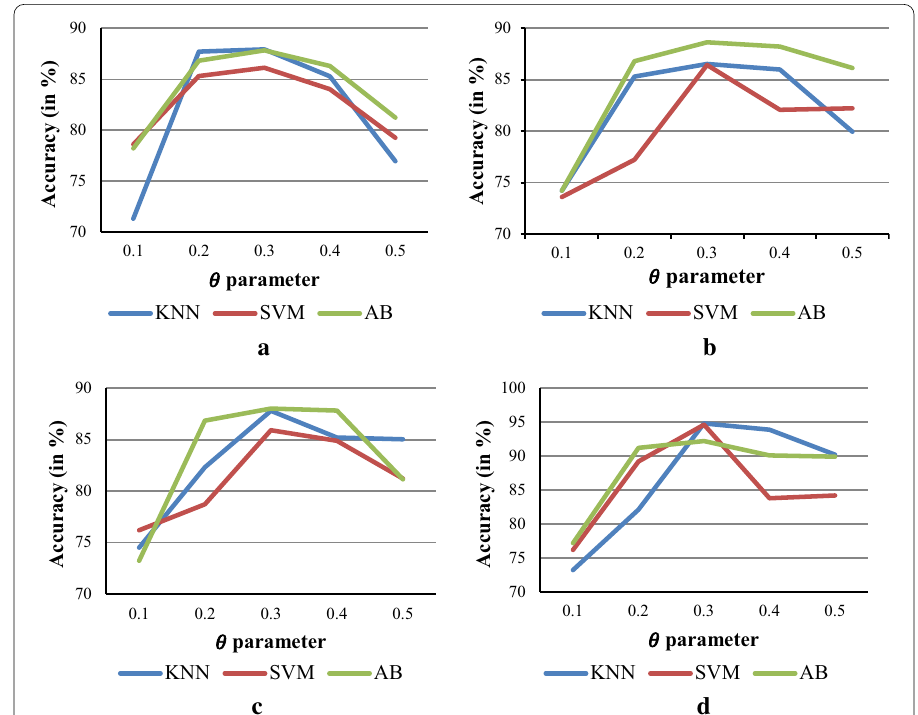
Fig. 10 Average classification accuracy (in %) over ten independent runs, with different θ values in KNN, SVM, and AB classifier on a Colon dataset, b SRBCT dataset, c Leukemia dataset, and d Prostate Tumor dataset